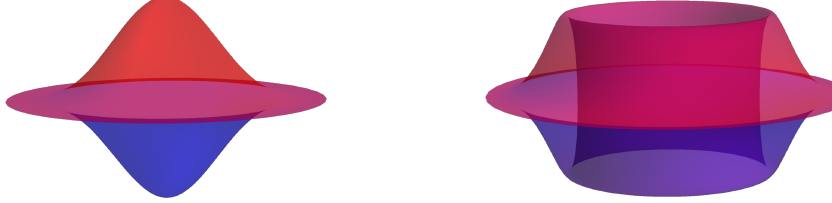
Figure 10 . The t = 0 surfaces of some string geometries with two sheets. The boundary is the spatial boundary circle of global AdS 3